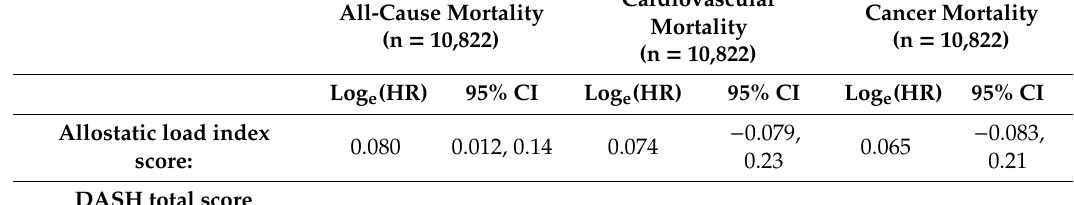
Table 5. Cox Proportional Hazard Models for Dietary Approaches to Stop Hypertension Diet and Allostatic Load Index Scores as Predictors of All-Cause and Cause-Specific Mortality—2001–2010 NHANES * (n =